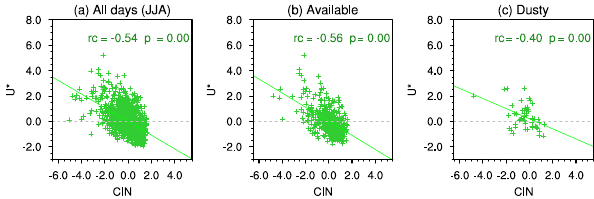
Figure 6. Scatter plot of standardized friction velocity ( U ∗ ) and CIN anomalies for (a) all days in JJA from 2002 to 2015, (b) days when fine dust data are available, and (c) dusty days (when daily fine dust concentration anomaly is greater than 1 standard